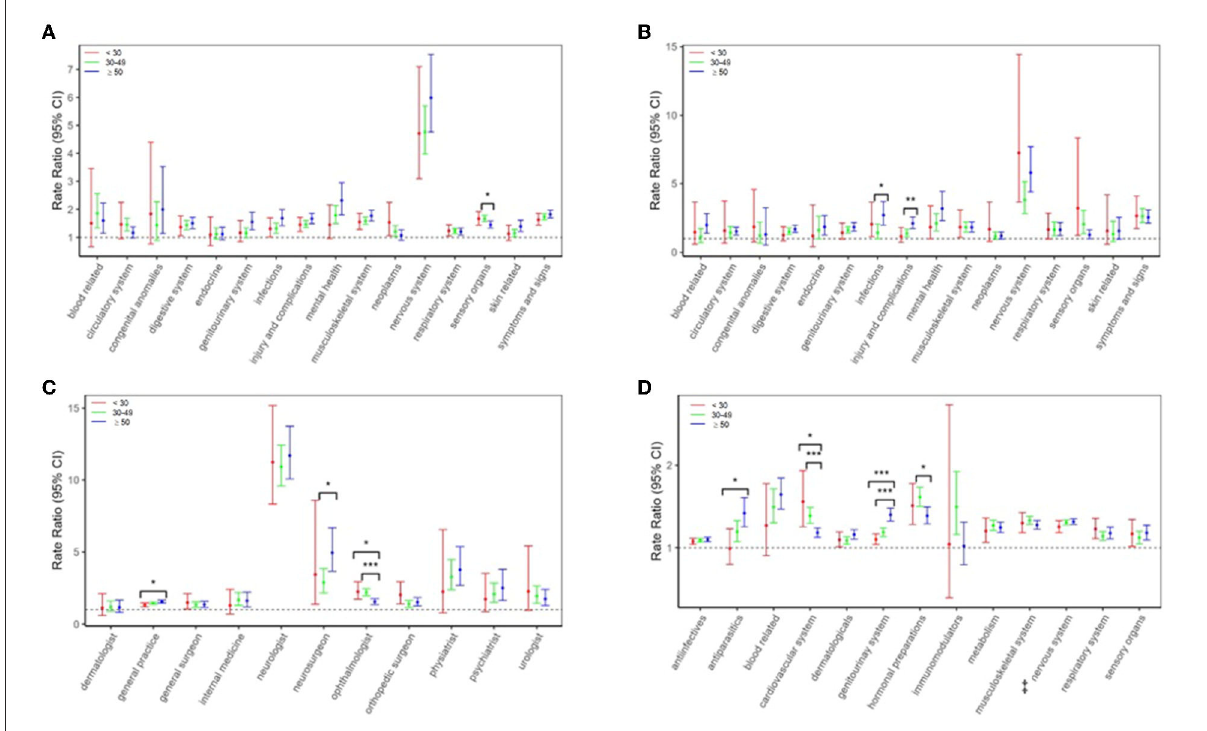
FIGURE2 Multiple Sclerosis (MS) cases vs. controls in the 5 years before the first demyelinating diagnostic code: age-specific rate ratios for (A) physician visits and (B) hospitalizations per International Classification of Diseases-9/10 chapter, (C) physician visits per specialty, and (D) prescriptions-filled per Anatomical Therapeutic Chemical (ATC) level 1 classification. Results were not reported if a model failed to converge due to low counts or the 95% CIs were wide (exceeded 100). * P < 0.05, ** P < 0.01, *** P < 0.001 indicates that the rate ratios are